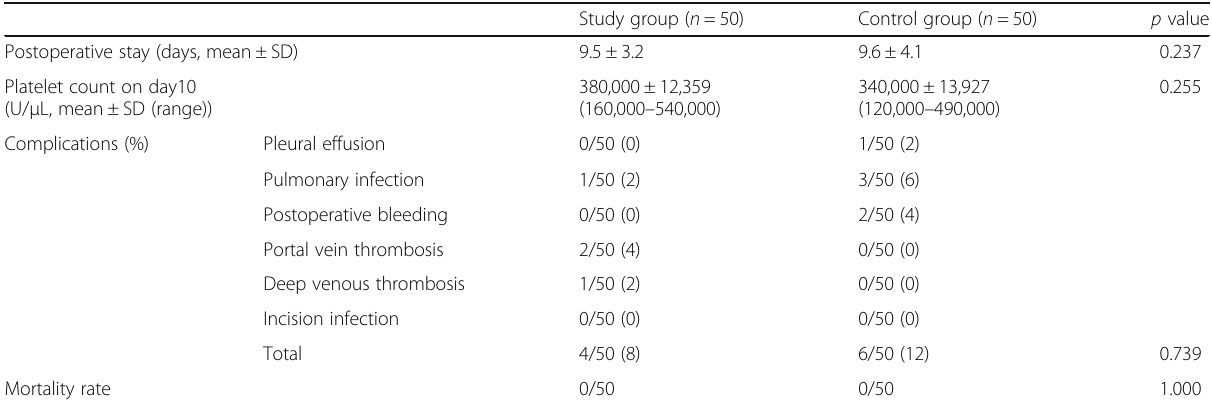
Table 3 Postoperative